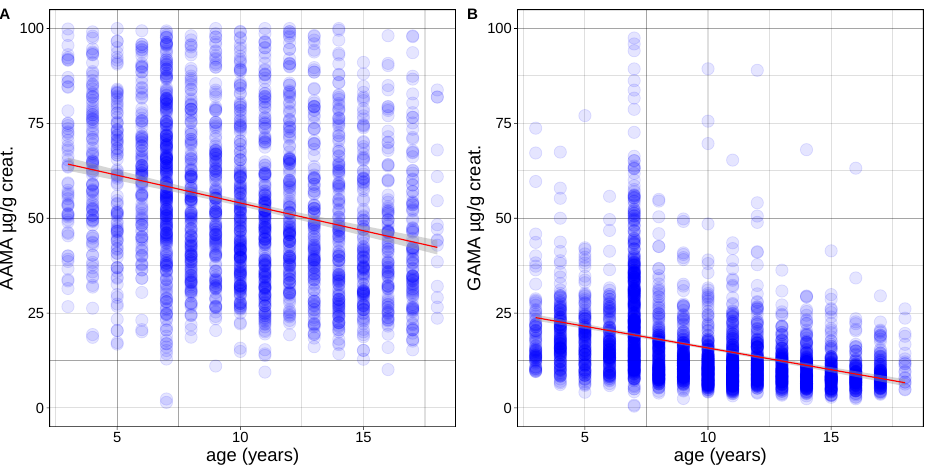
Figure 2. AAMA ( A ) and GAMA ( B ) (urine concentration in µg/g creatinine) in function of age in children and teenagers (3–18 years—from Germany (UBA, GerES V), France (ANSP, ESTEBAN) and Italy ( EPIUD, NAC II). Linear fit in red, gray = 95% confidence interval. Table 3. Estimated slope (s) and statistical significance of a multiple regression for AAMA and GAMA in µg/g creatinine (after normalization by logarithmic transformation using natural logarithm, ln) and age in years regression for AAMA and GAMA in µg/g creatinine and age in years in children and teenagers. ***: p < 0.001, **: p < 0.01. Variable AAMA (ln(µg/g Creat.)/Year) GAMA (ln(µg/g Creat.)/Year) Age